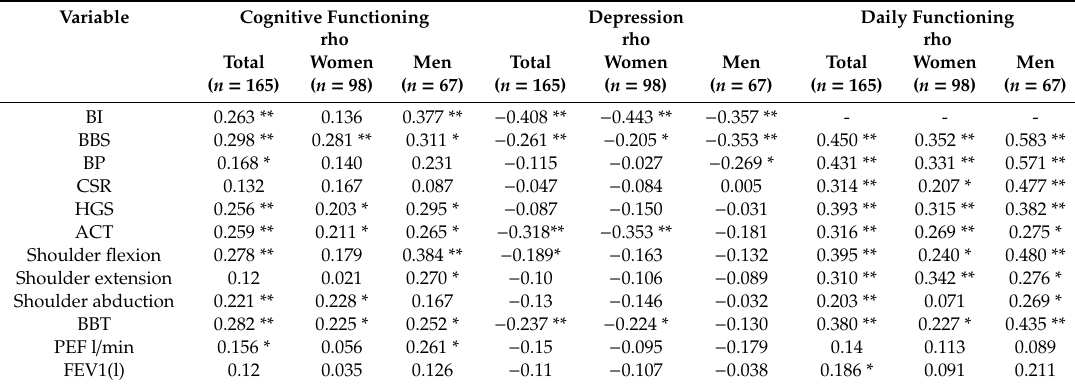
Table 2. Correlations between physical and mental health among older adults by sex.